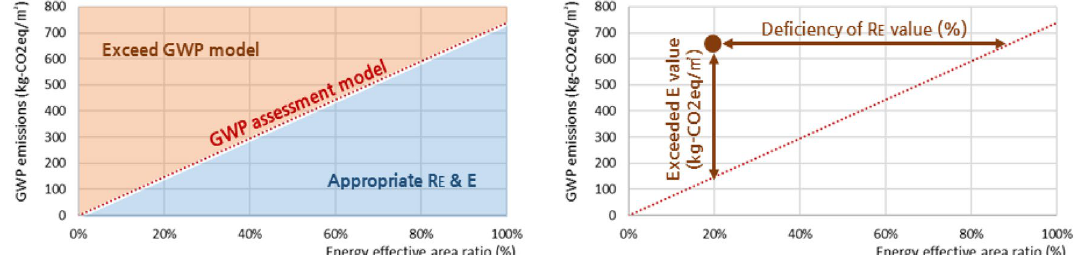
Figure 2. Use of global warming potential (GWP) assessment model.